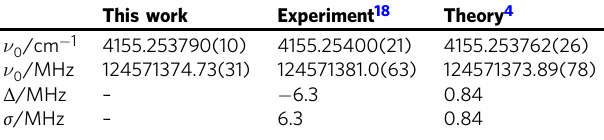
Table 1 Comparison between the frequency of the Q(1) 1-0 transition obtained in this work with the best available experimental 18 and theoretical 4 data.